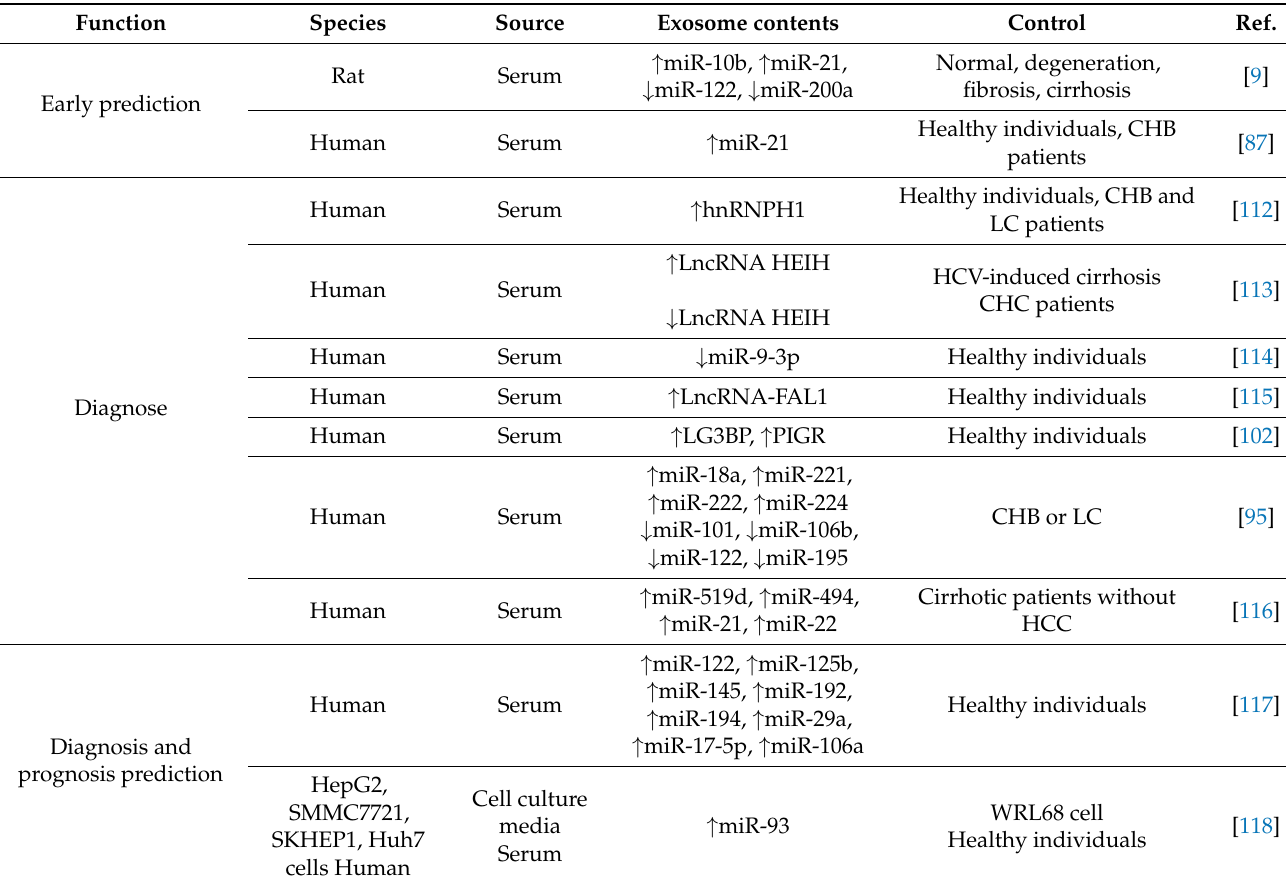
Table 2. Exosomes are used as biomarkers of